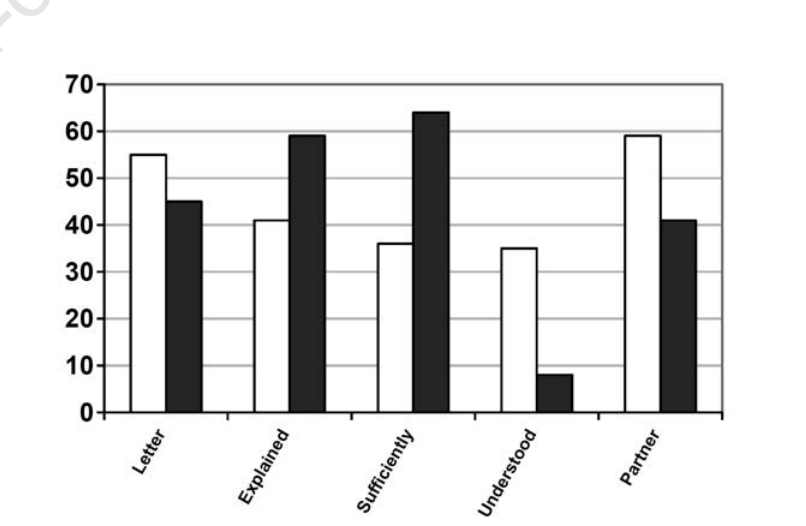
Figure 2. Education spectrum of the 100 individuals included in the anonymous enquiry.